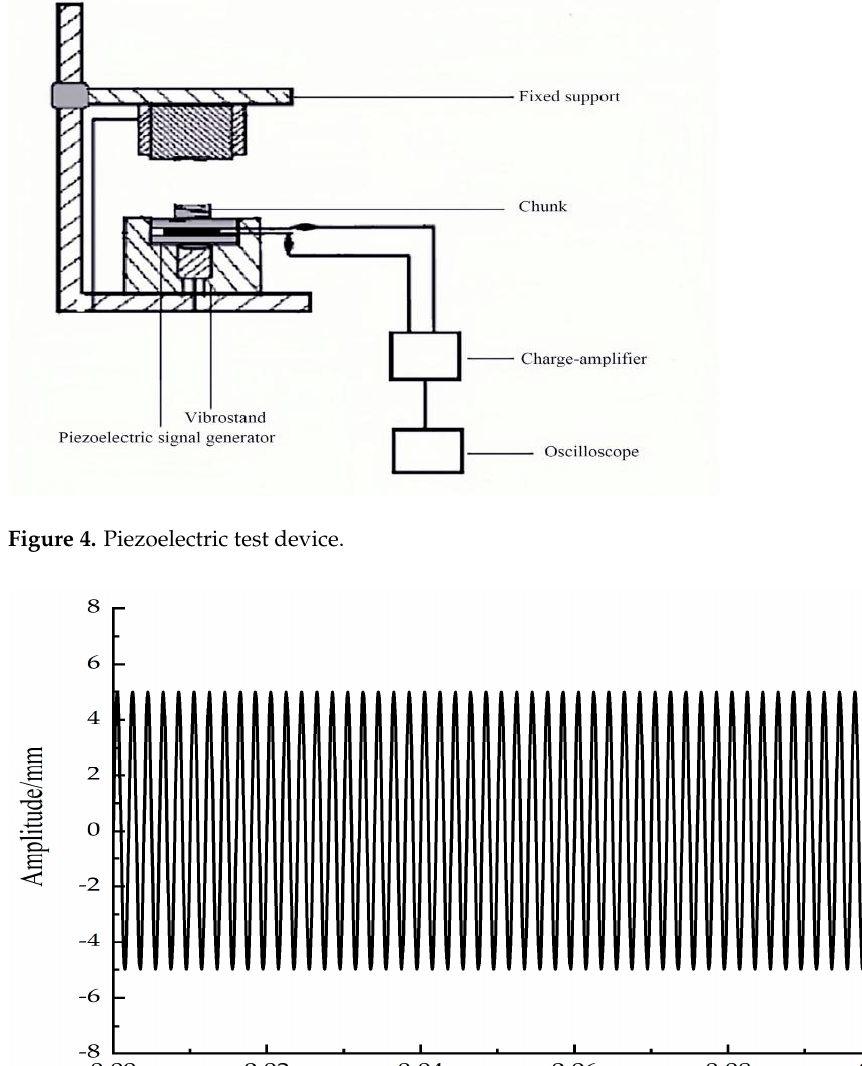
Figure 3. Piezoelectric signal generator.